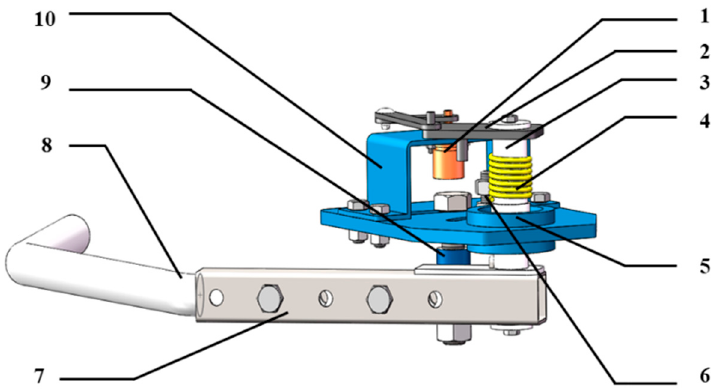
Figure 3. Touch to travel mechanism 3D modeling (1) Angle sensor (2) Four-rod mechanism (3) Rotation shaft (4) Reset torsion spring (5) Bearing (6) Adjustable fixed torsion spring fixing bolt (7) Touch rod fixing sleeve (8) Touch rod (9) Limit sleeve (10) Fixing frame.